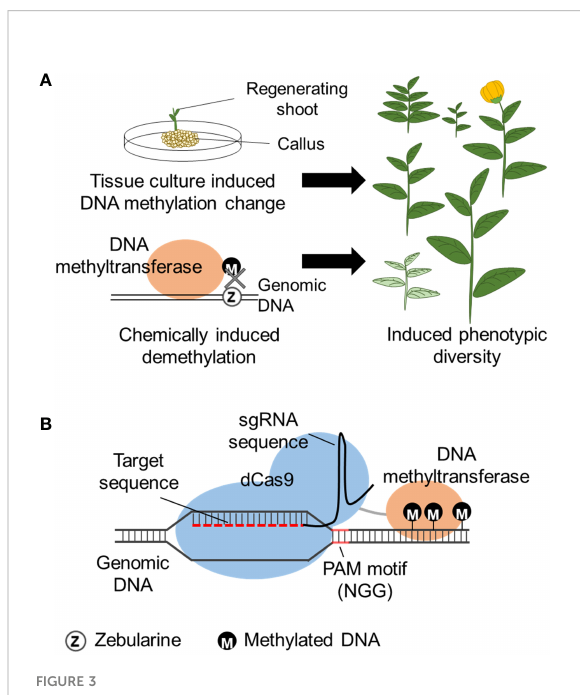
FIGURE 3 Methods to induce epigenetic changes. (A) DNA methylation is altered during tissue culture, or chemical (zebularine) induced random DNA demethylation by inhibition of DNA methylation, leading to gene expression change and induced phenotypic diversity. (B) CRISPR/dCas9 induced DNA methylation by fusion of DNA methyltransferase to the dCas9 protein. The dCas9 fusion protein is directed to the homologous regions (target sequence) of the designed sgRNA and induces methylation to the fl anking DNA region. The target sequence requires a PAM motif (N can be A, C, G or T) within the sgRNA